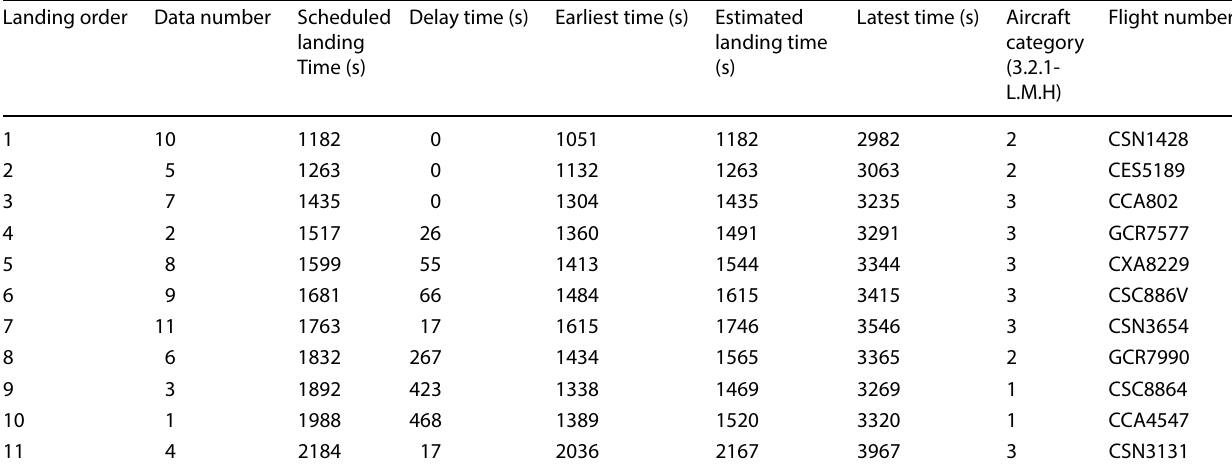
Table 2 Results of test1 of FCFS Landing order